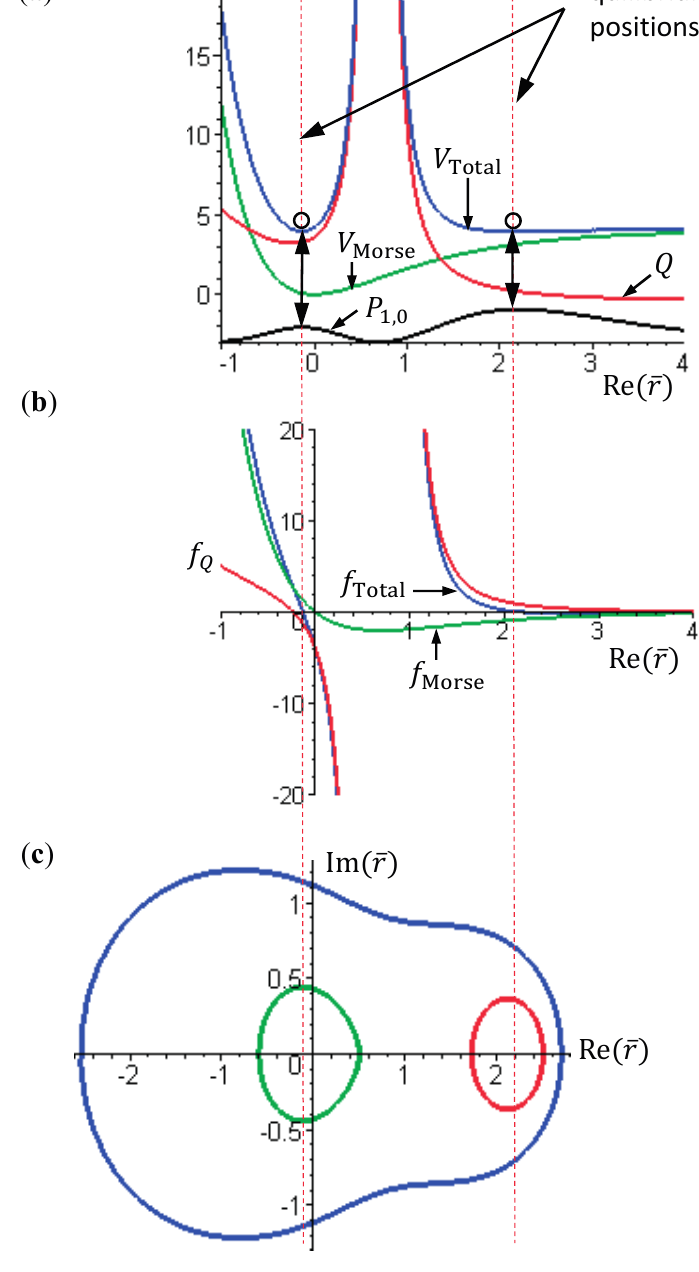
Figure 2. Illustration of the coincidence of four positions for the state with (cid:1866) = 1 and (cid:1836) = 0 : ( a ) The local minimum of the total potential (cid:1848) probability (cid:1842) ; ( b ) The position free from the radial force (cid:1858) (cid:2869),(cid:2868)